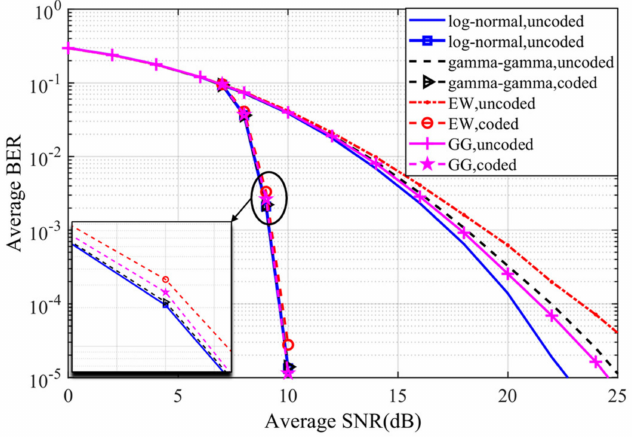
Figure 5. BERs of the (6, 3) MPPM UWOC system with/without LDPC code in the same weak turbulence channel modeled by different statistical distributions.